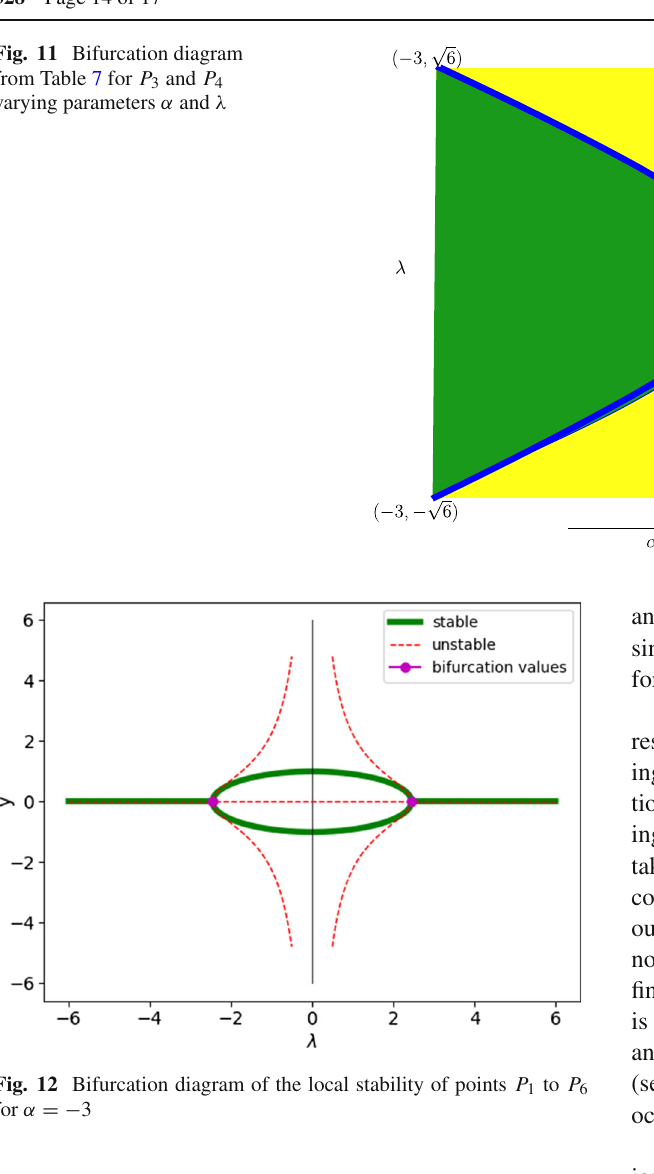
bifurcation. Similar behavior of dynamics can be found for √ λ = 6 also.